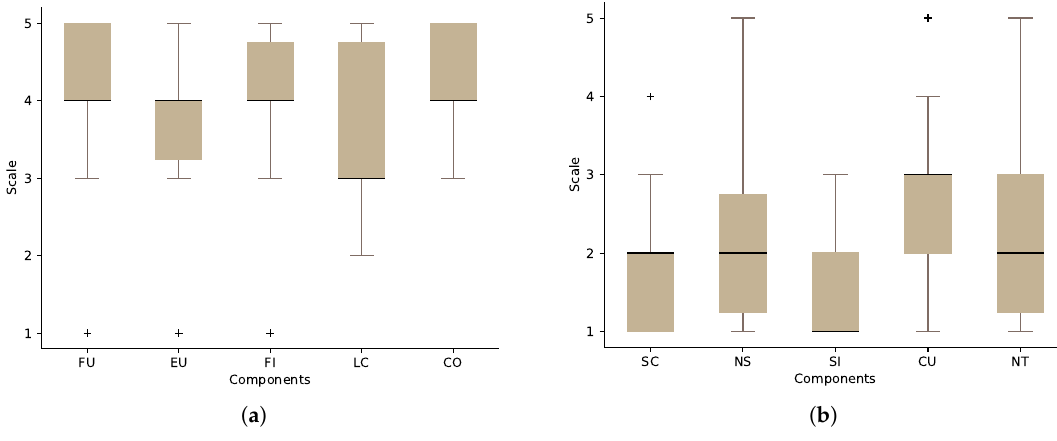
Figure 8. The result of System Usability Scale (SUS) questionnaire for the researchers’ group. ( a ) The positive components; ( b ) the negative components.